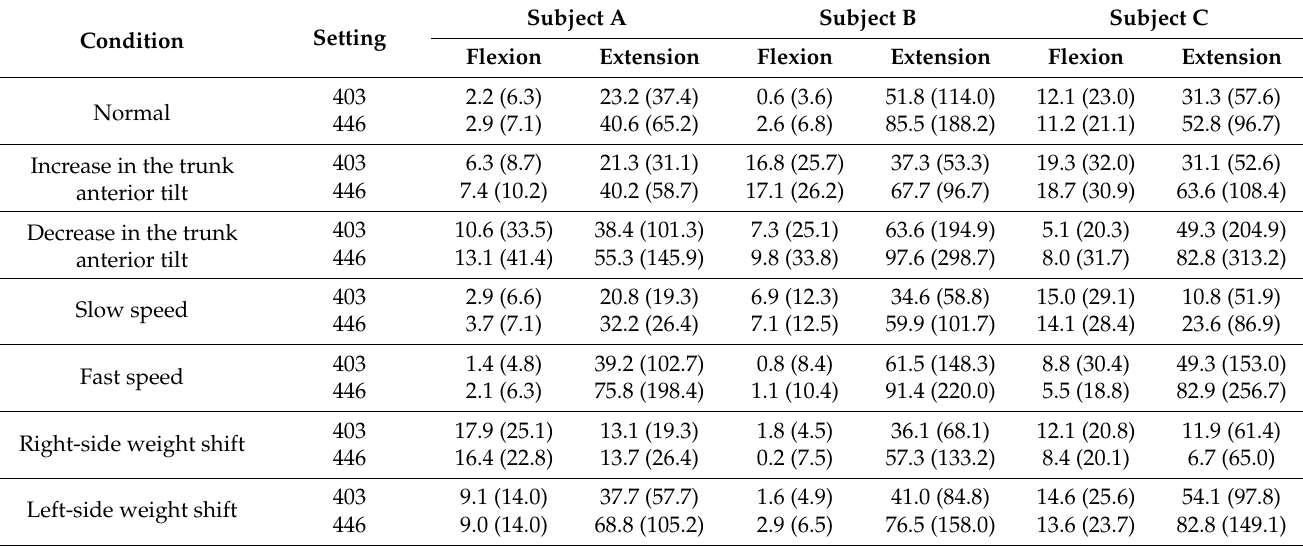
Table 3. Absolute errors of joint angular excursions in the flexion and extension phases calculated using the chair with embedded laser range finders and the optical motion capture system.